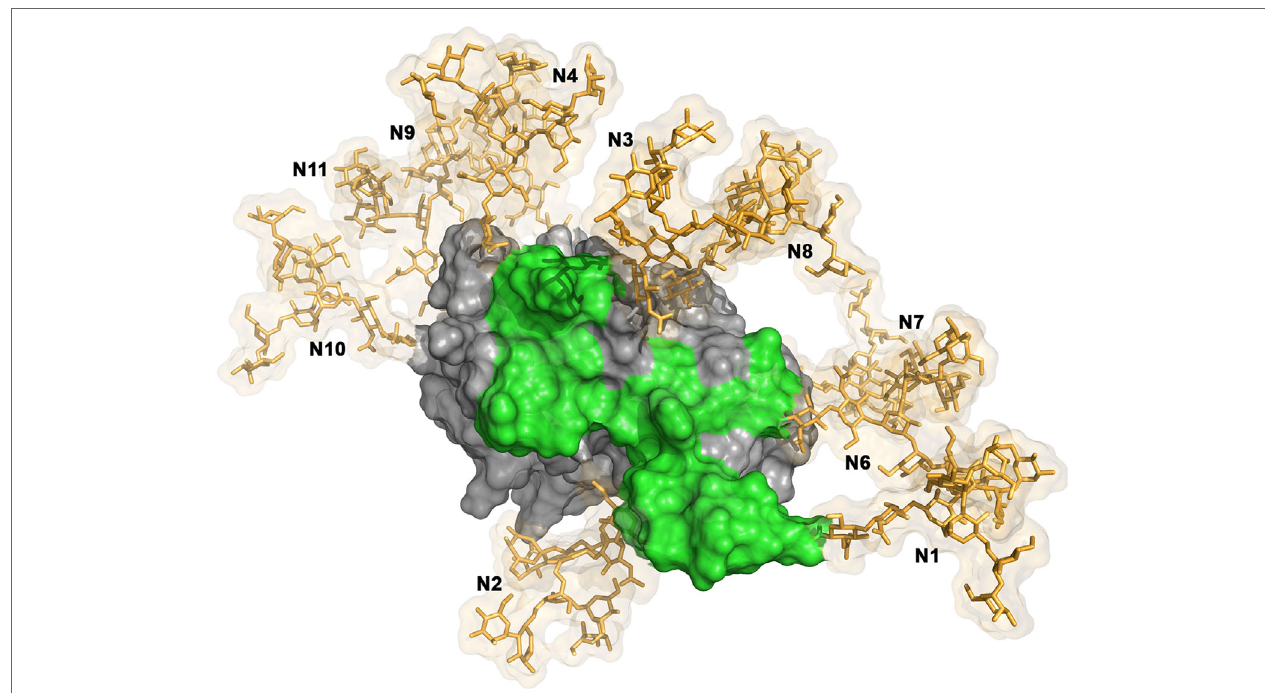
FiGURe 2 | Glycan shield masking E2 neutralizing epitopes. The model of E2 structure is composed by the E2 core structure (PDB ID: 4MWF) (20) and its N-terminal antigenic region 412–423 (PDB ID: 4DGY) (23). The E2 structural model has been built in a similar way than in Fuerst et al. (24). The hypervariable region 1 located at the N-terminus of E2 is not shown. The E2 molecular surface is displayed in gray and its neutralizing epitopes are highlighted in green. High mannose N-glycans (Man9GlcNac2) have been modeled at the 10 N-glycosylation sites available in the E2 structural model using the Glycoprotein Builder tool of the GLYCAM-webserver (http://glycam.org), with an energy minimization step. The glycans (N1, N2, N3, N4, N6, N7, N8, N9, N10, and N11) are shown in sticks representation (in gold) with their transparent molecular surface. The figure was generated with PyMOL (The PyMOL Molecular Graphics System, Version 1.83 Schrödinger,